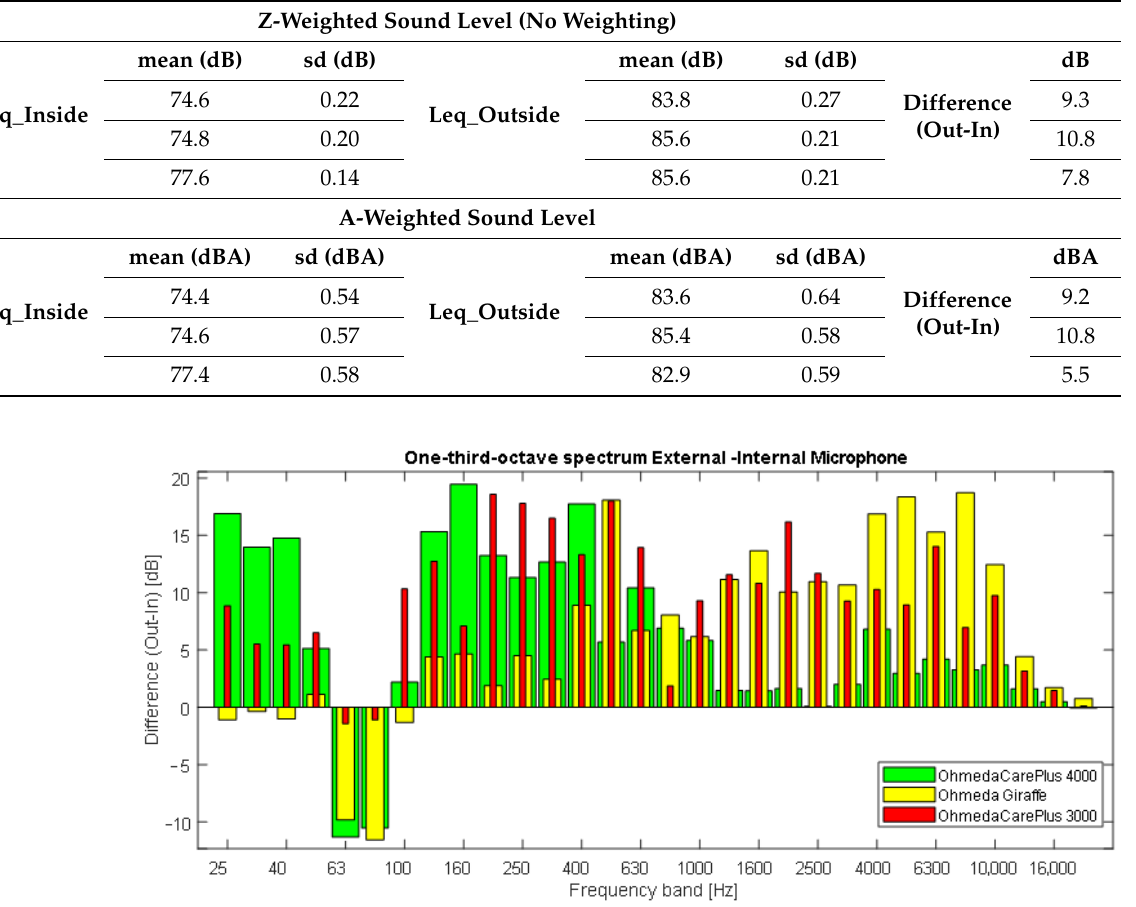
Figure 3. Incubators off and external source on: spectral difference between outside and inside the incubator (dB).